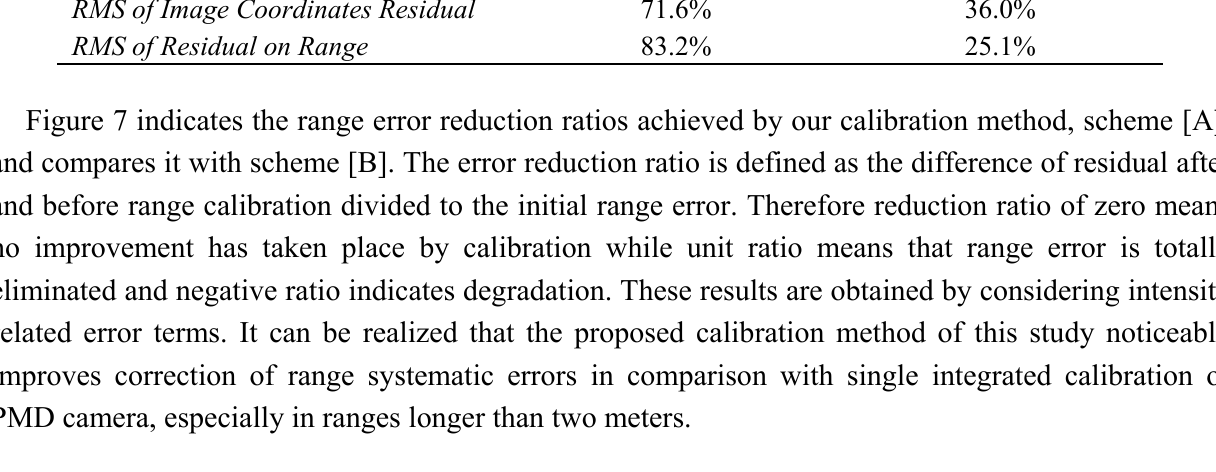
Figure 7. Range error reduction ratio provided by calibration schemes [A] and